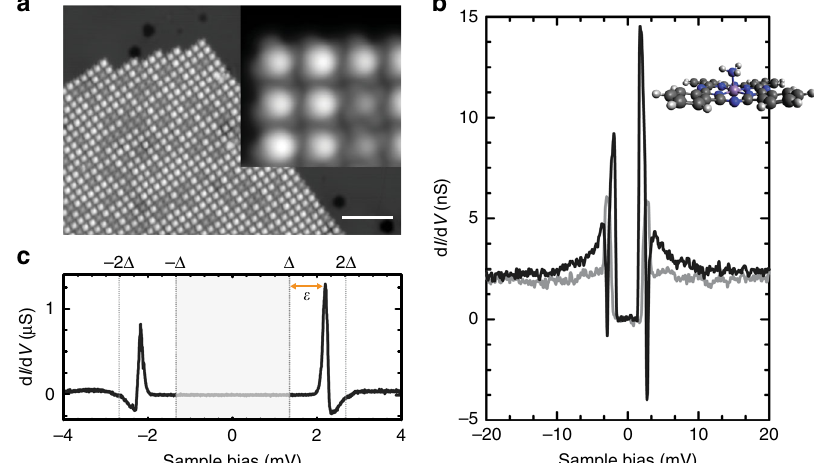
Fig. 1 MnPc – NH 3 on Pb(111). a Topography of a mixed island of MnPc – NH 3 and MnPc molecules (setpoint: U = 50 mV, I = 100 pA; scale bar is 10 nm). The inset shows a zoom on seven MnPc – NH 3 and two MnPc molecules (50 mV, 200 pA). b Characteristic d I/ d V spectrum of an MnPc – NH 3 (black) and on the bare Pb(111) (gray) acquired with a superconducting Pb tip (50 mV, 200 pA, U mod = 500 μ V rms ). c Zoom on the superconducting gap presenting a pair of YSR resonances (5 mV, 200 pA, 20 μ V rms ). The bound-state energy is indicated by ε and the tip gap by the gray